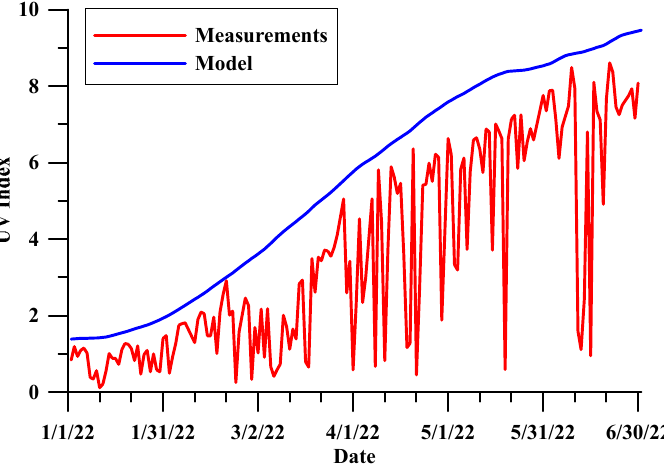
Figure 6. Trend of measured UV-Index values at 11UTC in 2022 (solid red line) and estimated clear-weather index values obtained from data before 2022 (solid blue line).